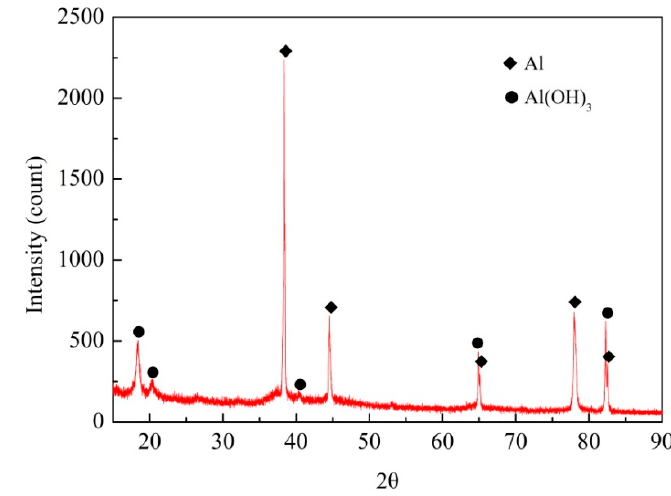
Figure 5. XRD spectrum of exfoliation corrosion products.